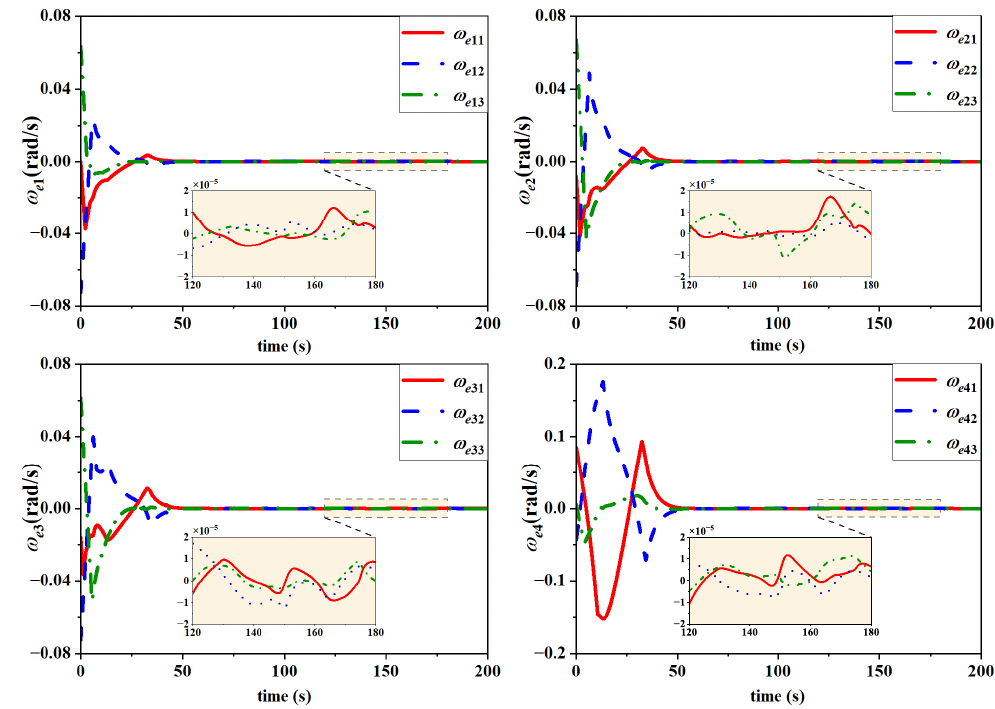
Figure 4. Attitude angle velocity tacking error trajectories of four